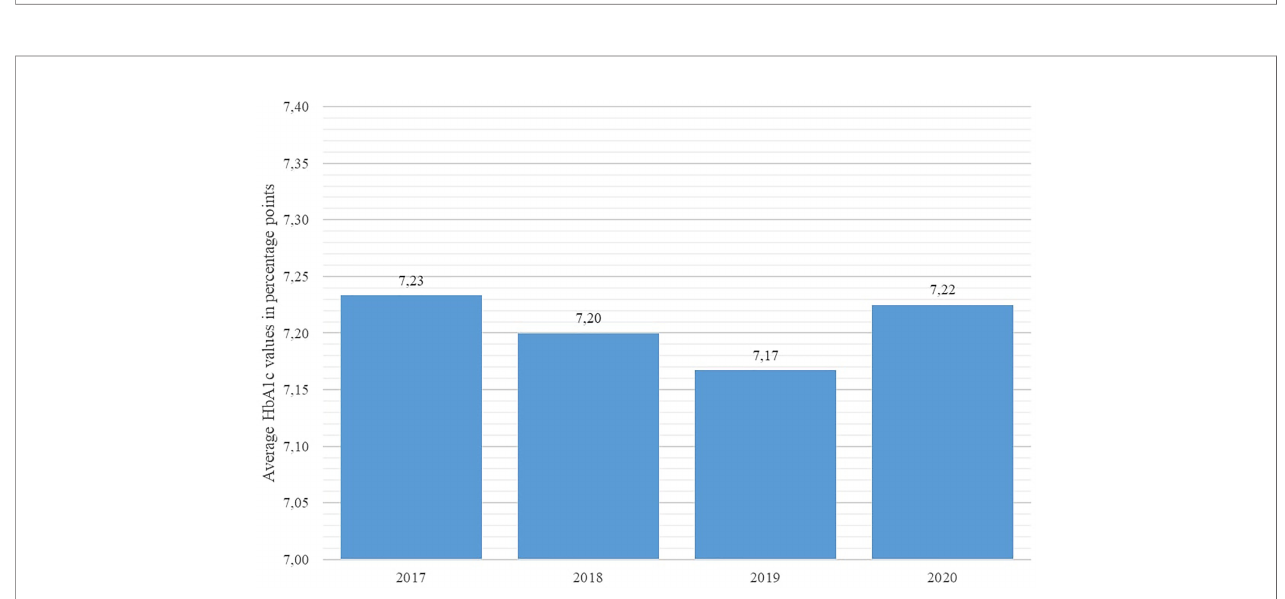
FIGURE 7 | Average HbA1c percentages in diabetes patients in Croatia per year, 2017 - 2020.